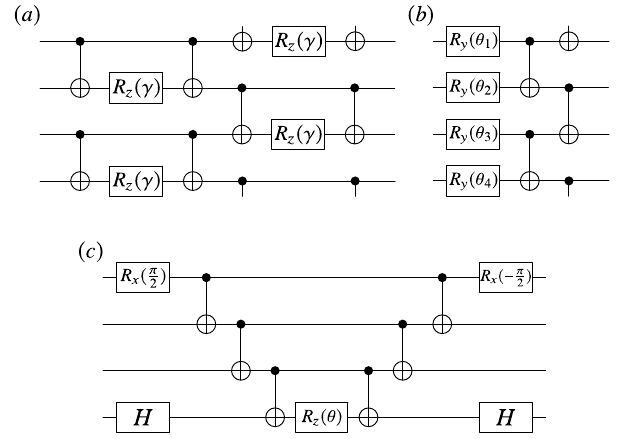
Fig. 6 Special cases of our general ansatz. a QAOA problem unitary e (cid:2) i γ H P for the ring-of-disagrees MaxCut problem, with Hamiltonian H single qubit rotations around the y -axis R y ( θ ). c Unitary for the exponential e (cid:2) i θ Y 1 Z 2 Z 3 X 4 . This type of circuit is a representative component of the UCC